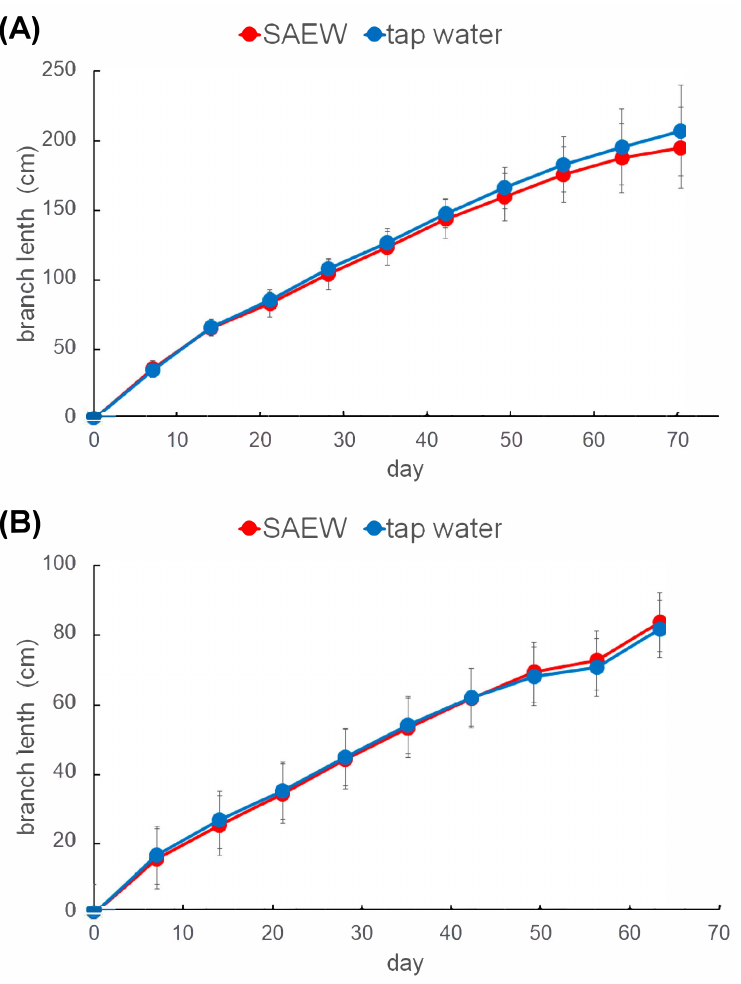
Figure 5. Growth of plants in the greenhouse. ( A ) The growth of four branches of six cucumbers in greenhouse area A sprayed with SAEW (red circles), and area B sprayed with tap water (blue circles) was measured weekly. The average of branch lengths with SD was shown. ( B ) The growth of two branches of six eggplants was